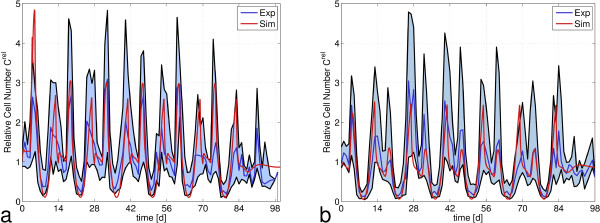
Comparison of the predictions of the hybrid model with clinical data on leukocyte dynamics in peripheral blood during chemotherapy with G-CSF support. Clinical data of a) CHOP-14 and b) CHOEP-14 administration (Blue: median of patients, black: 25 and 75 percentiles) are compared with corresponding simulation results of the hybrid model (red). The effect of growth factor support is reflected by the peak approximately one day after starting the G-CSF treatment at day 4 in each cycle. As for the regimens without G-CSF, simulation results fit well to clinical data. Cell numbers are normalized with respect to the average WBC/leukocyte count value of healthy individuals (7000 cells/μl).